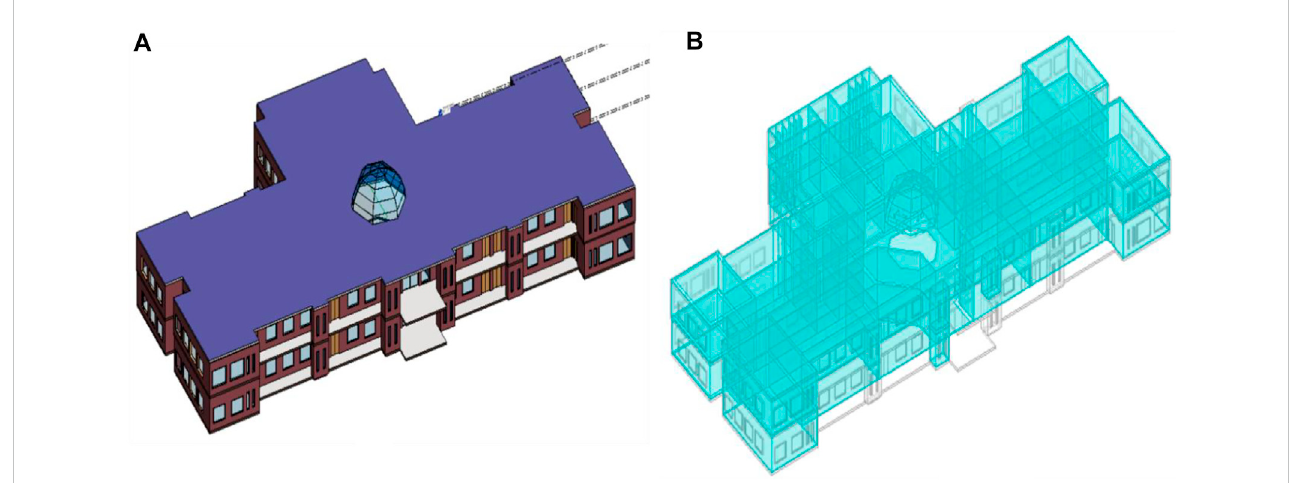
FIGURE 1 (A) Existing 3D BIM model, (B) Energy model visualization of the